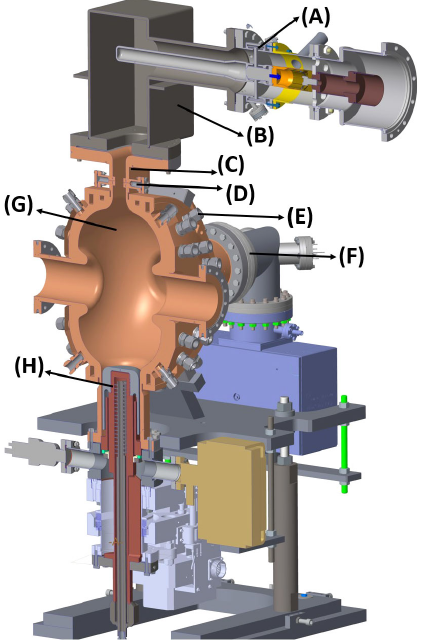
FIG. 3. A 704 MHz cavity cross section view. (a) Toshiba rf window; (b) WR1150 waveguide to coaxial transition piece; (c) FPC port; (d) FPC tuner; (e) cavity water cooling channel; (f) vacuum pump; (g) cavity body; (h) main frequency